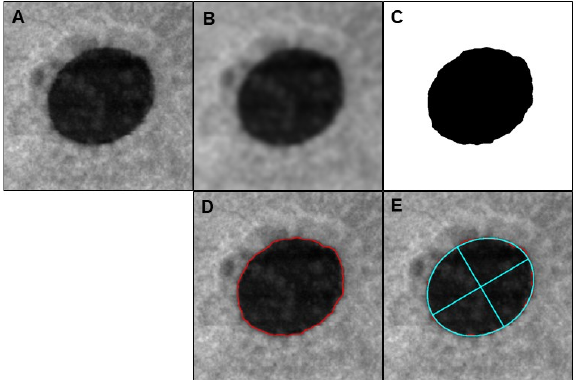
Figure 1. Identifying the center of the macular hole automatically in the en face images. ( A ) Original en face image ( B ) Blurring for smoothing edges ( C ) Binarization ( D ) Extraction the edge of macular hole ( E ) Centroid: detecting pore and its center of gravity.